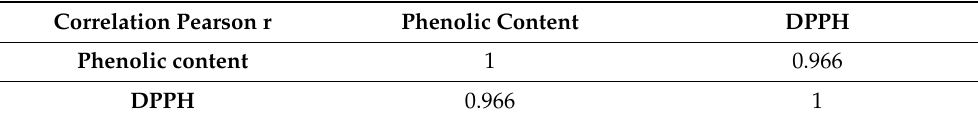
Table 2. Pearson’s correlation coefficients between phenolic content and DPPH radical scavenging activity (IC 50 ) of Taraxacum officinale essential oil.